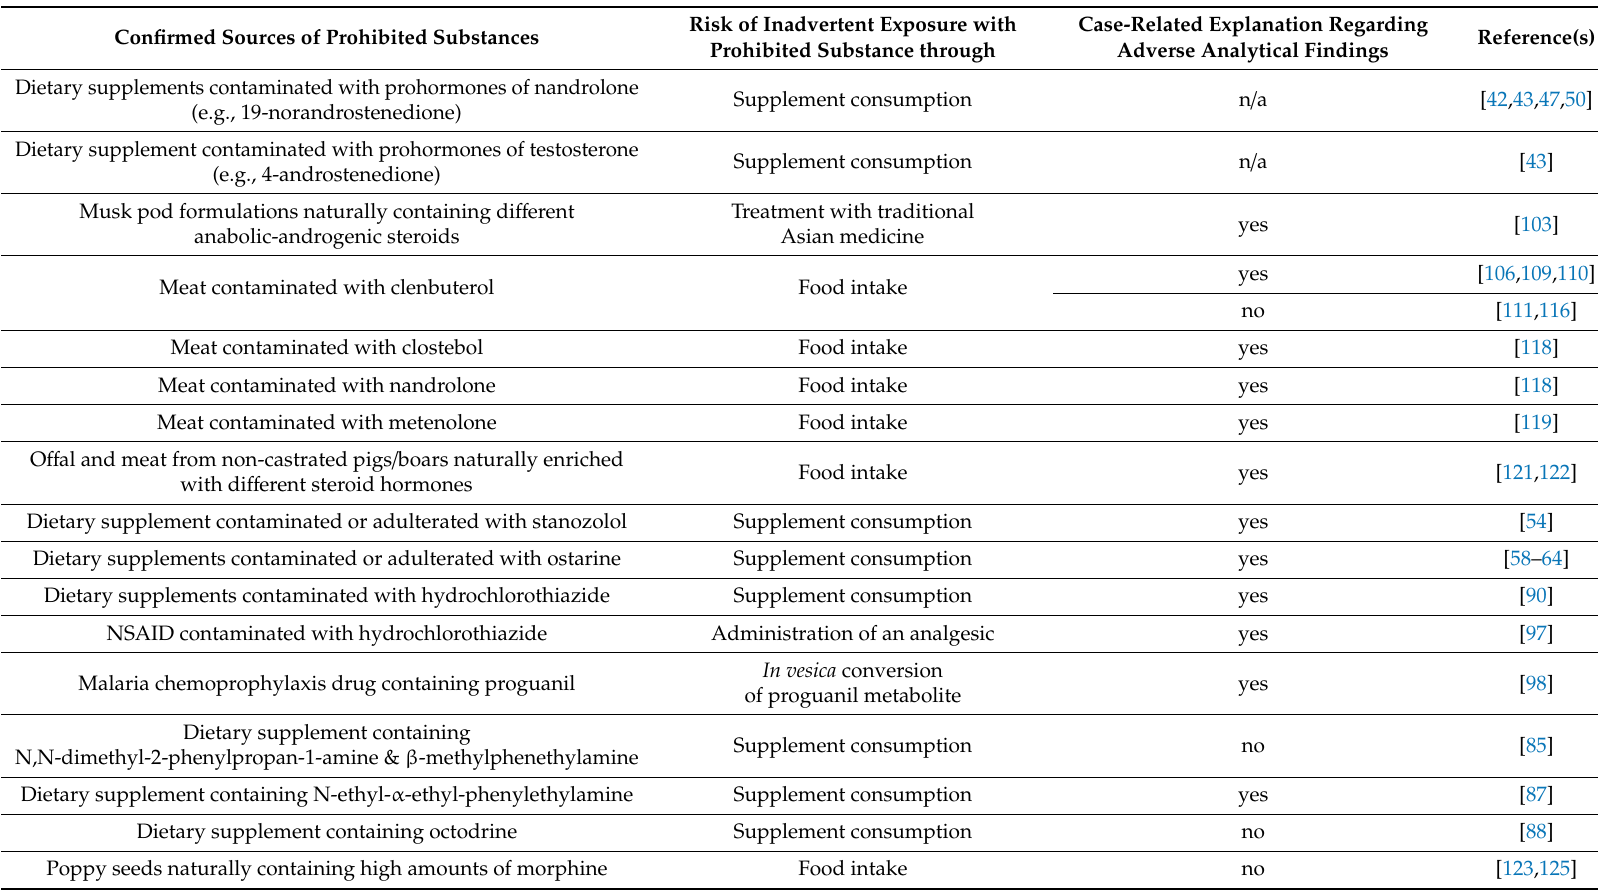
Table 1. Summary of findings. Various prohibited substances were detected as contaminants in dietary supplements, food products, or regular therapeutics that potentially or plausibly resulted in cases of adverse analytical